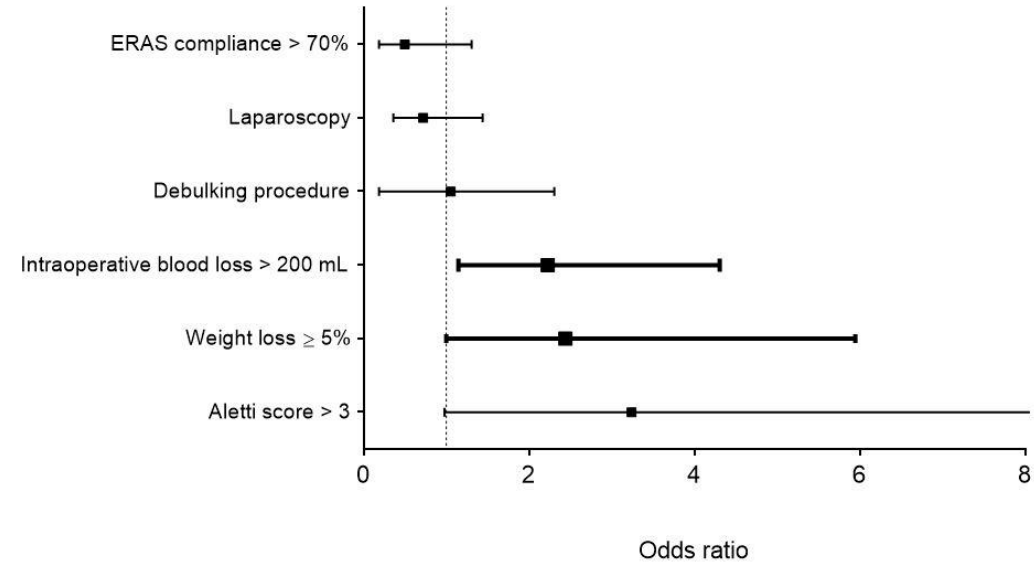
Figure 3. Multivariable analysis of significant univariate demographic and surgical risk factors associated with postoperative complications ( n = 84). Displayed are odds ratios (black squares) and 95% confidence intervals (black lines). Significant associations ( p < 0.05) are represented in bold. ERAS: enhanced recovery after surgery.